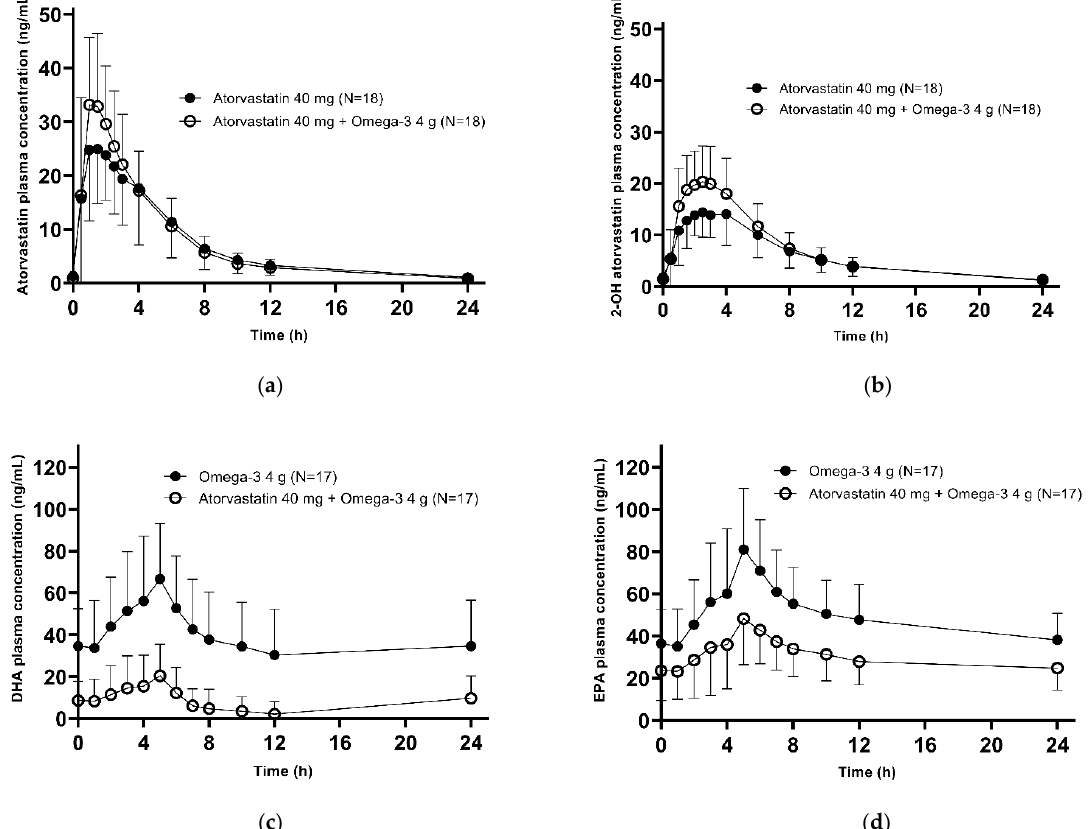
Figure 1. Mean plasma concentration-time profiles of ( a ) atorvastatin, ( b ) 2-OH-atorvastatin, ( c ) baseline-corrected DHA, and ( d ) baseline-corrected EPA after multiple oral administration as single drug administration vs. co-administration with a linear scale. The error bars represent the standard